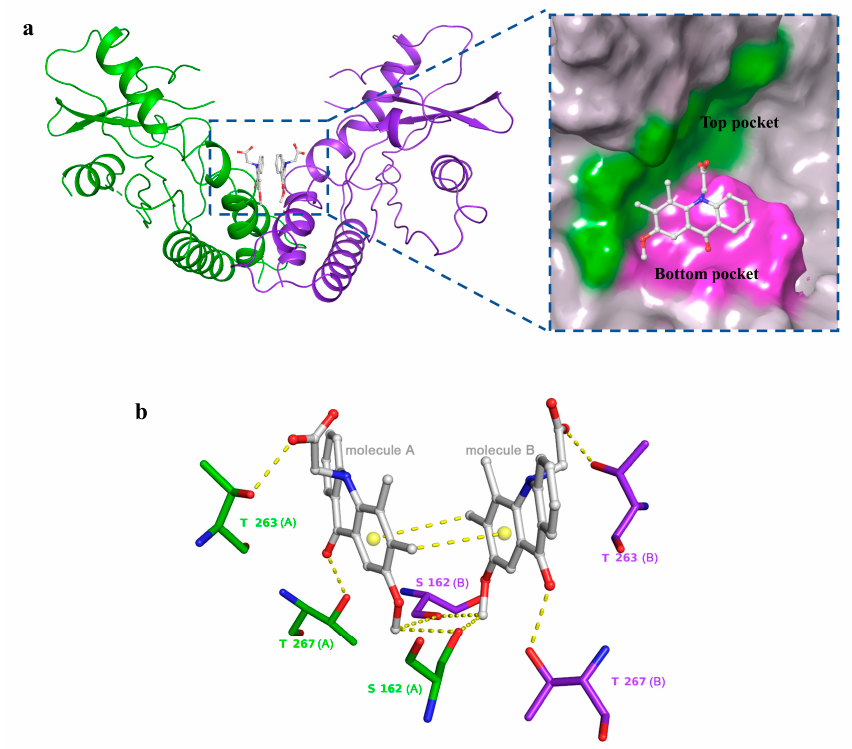
Figure 8. Docking structure of compound 11 bound to STING protein. ( a ) Binding mode of compound 11 . The bound ligand is shown in gray color, with individual STING subunits in the symmetrical dimer shown in green and purple. In the binding pockets of the STING monomer, the bottom is colored magenta and the top is green. ( b ) The intermolecular contacts of compound 11 bound to STING. Compound 11 and contacted STING amino acids are shown as a stick model. The intermolecular contacts and hydrogen bonds are shown with a yellow dashed line. The A and B superscripts indicate protein monomer or individual ligand identity.